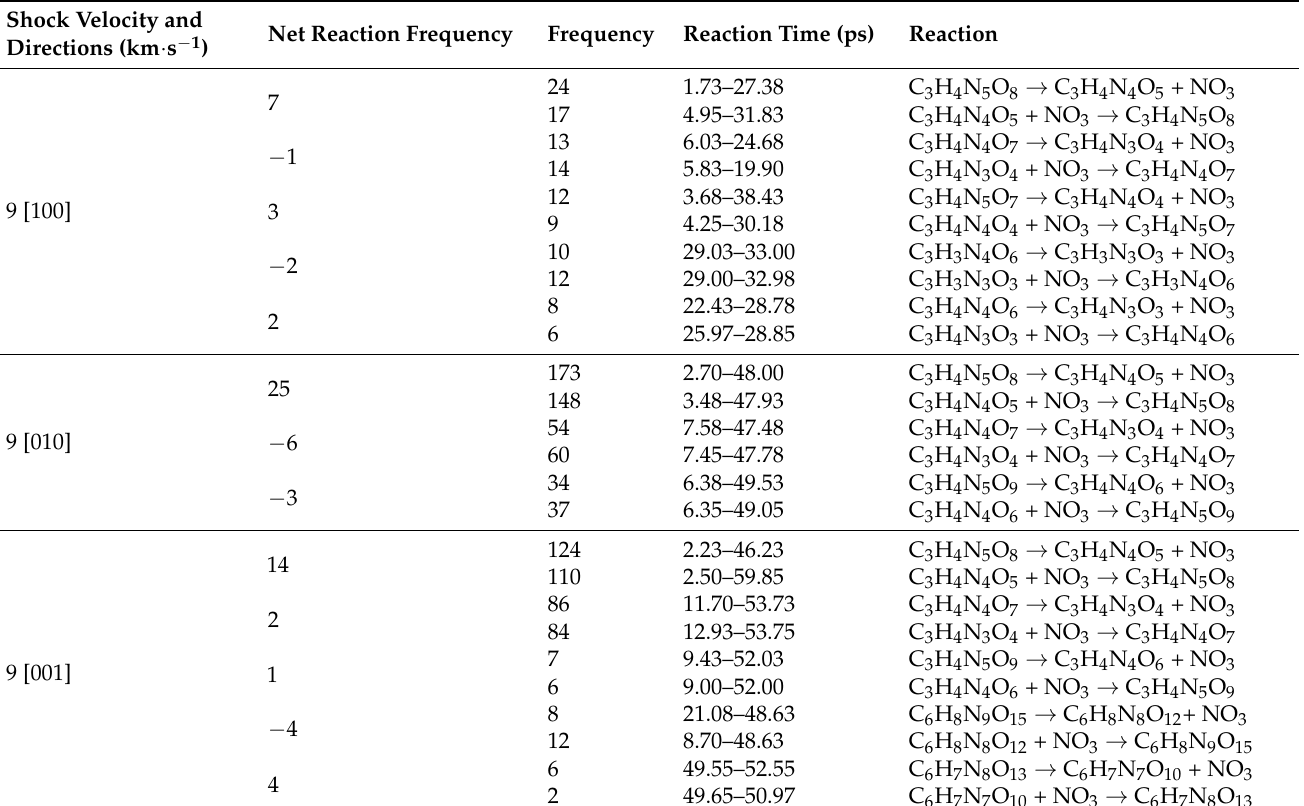
Table 6. Reactions of NO 3 molecule